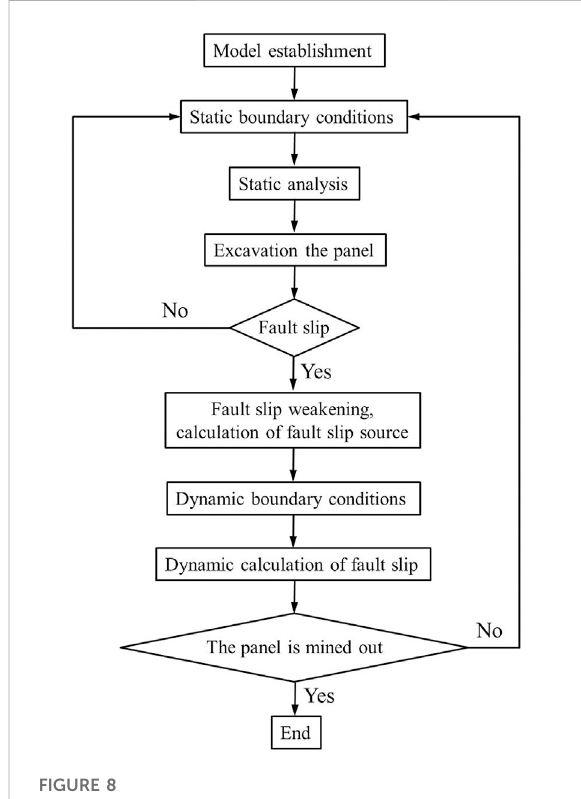
FIGURE 8 Flow chart of dynamic calculation.